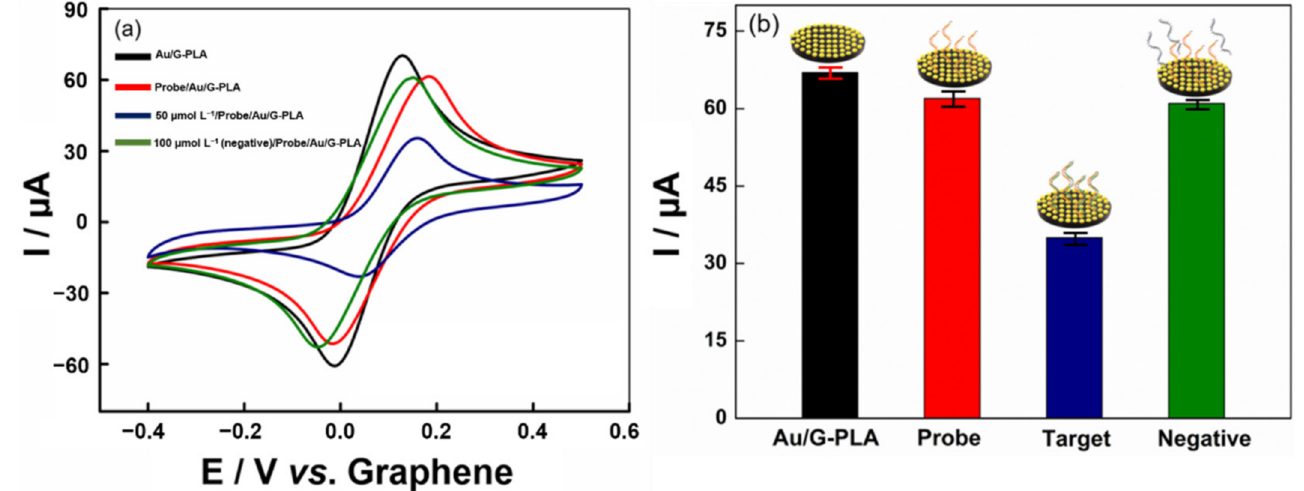
Figure 7. ( a ) Comparison between target sequences positive (50 µ mol L − 1 ) and negative (100 µ mol L − 1 ). Cyclic voltammograms obtained in the presence of 1.0 mmol L − 1 ferrocenemethanol in 0.1 mol L − 1 KCl. The scan rate was 100 mV s − 1 , ( b ) Bar column